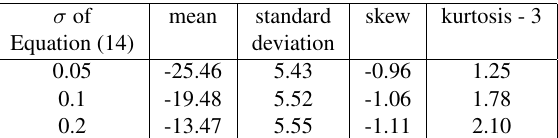
Table 1. Statistics of probability density functions expressed by Equation (14)